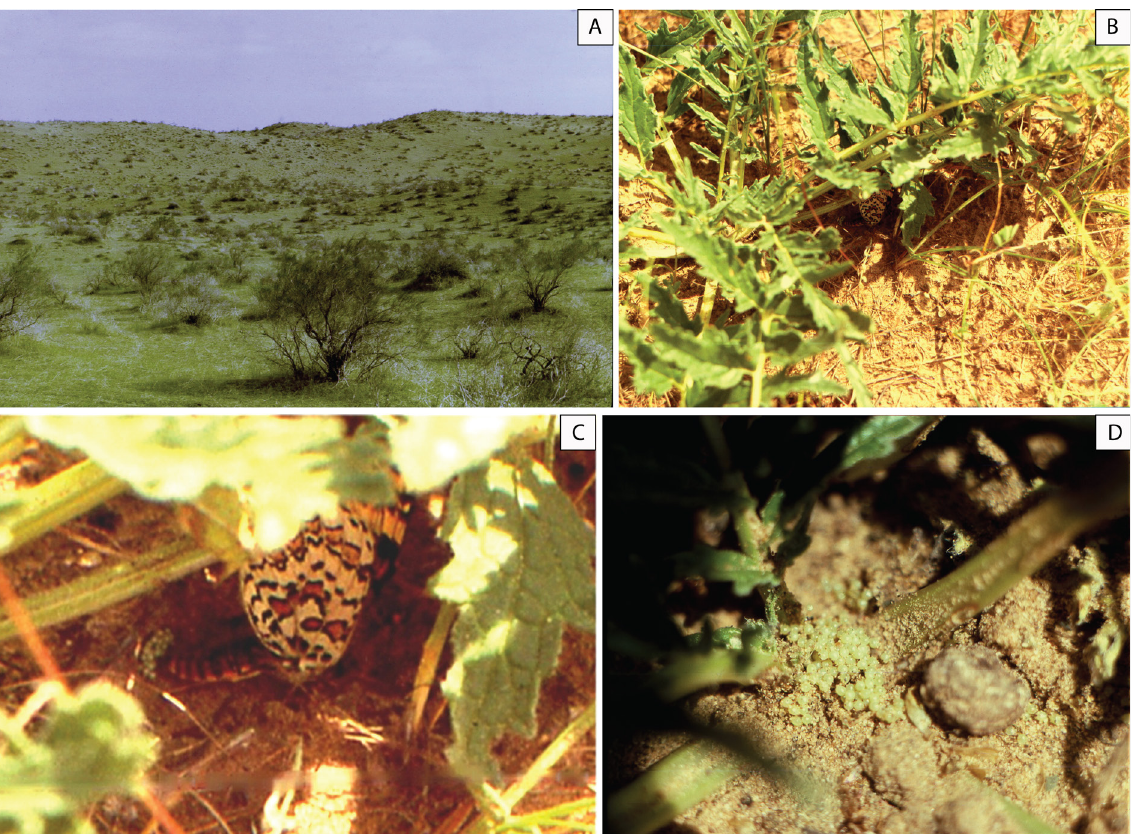
Fig. 13. Biotopes and biology of Melitaea timandra timandra Coutsis & van Oorschot, 2014. A . Bumpy- cellular overgrown sands on the left bank of the Murgab River, alt. 300 m, April 1993, the habitat of M. timandra timandra . B . Phlomoides regeliana (Aitch. & Hemsl.) Adylov, Kamelin & Makhm. – host plant for M. timandra timandra . The female laying eggs is visible under the leaves of the plant. C . The female of M. timandra timandra is ovipositing on the soil under the host plant leaf. D . Egg clutch of M. timandra timandra on the basal leaf rosette of Ph. regeliana